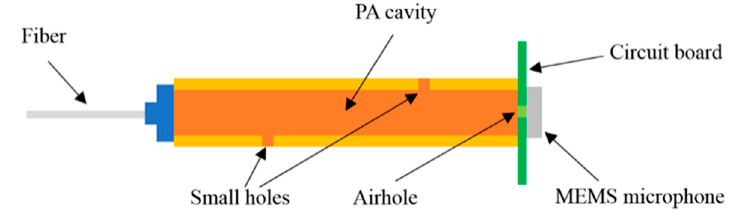
Figure 1. Structure diagram of the photoacoustic (PA) microcavity sensor.